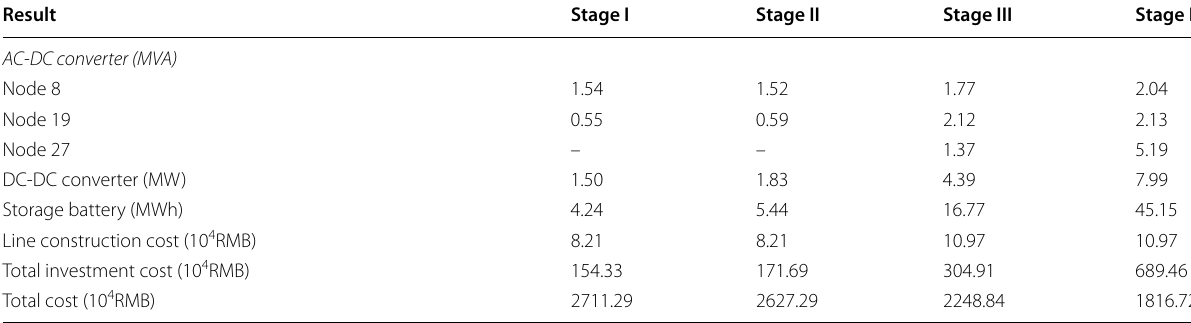
Table 7 Multi-stage planning results in Case IV